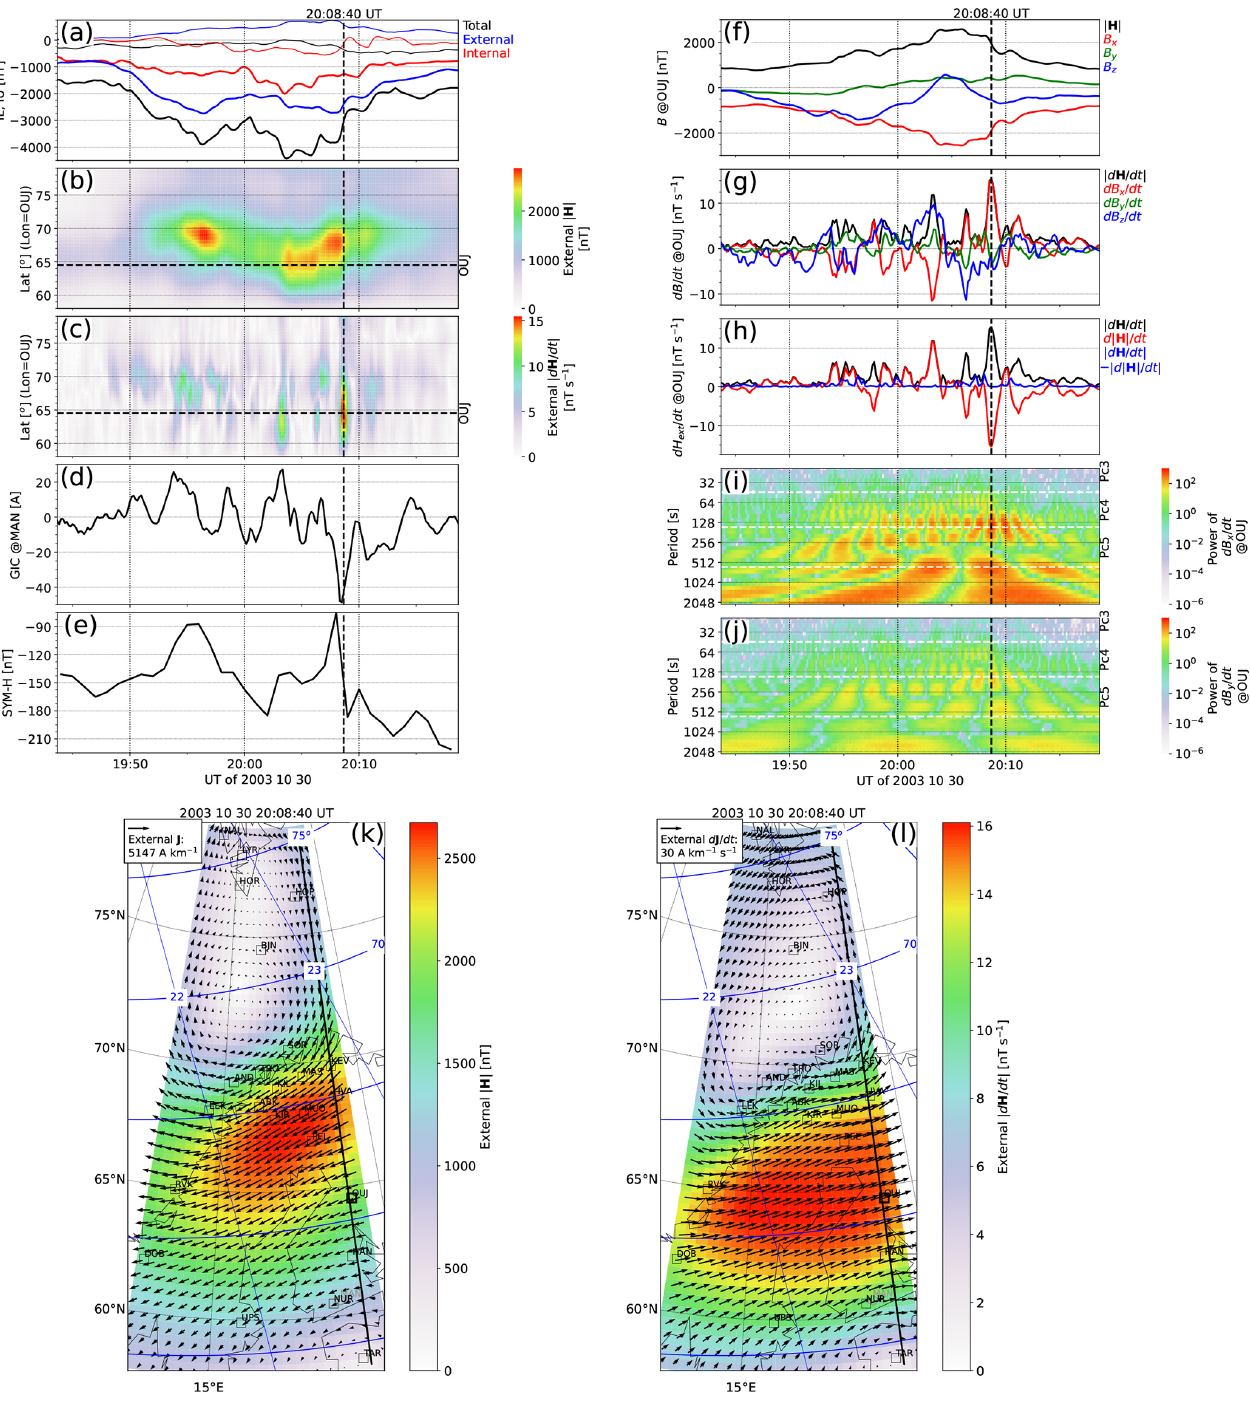
Figure 5. Data in a format similar to combined Figs. 3 and 4c–d from − 25 to + 10min around the event on 30 October 2003 at 20:08:40UT.